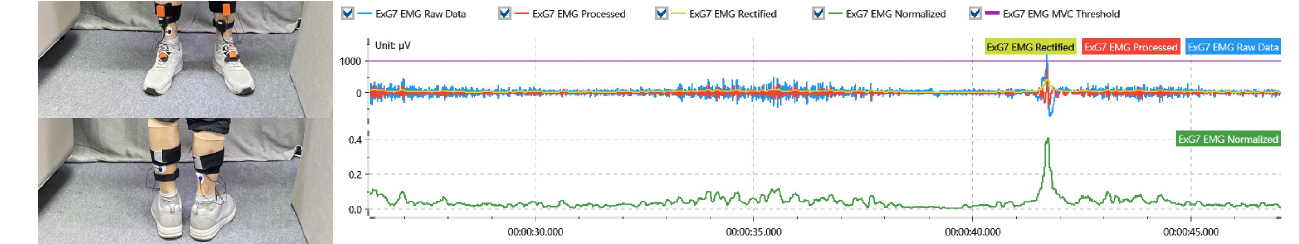
Figure 15. EMG multi-channel data acquisition experiment site. EMG was applied to the gastrocne- mius muscle of the leg and the subject’s exertional state was determined by the EMG